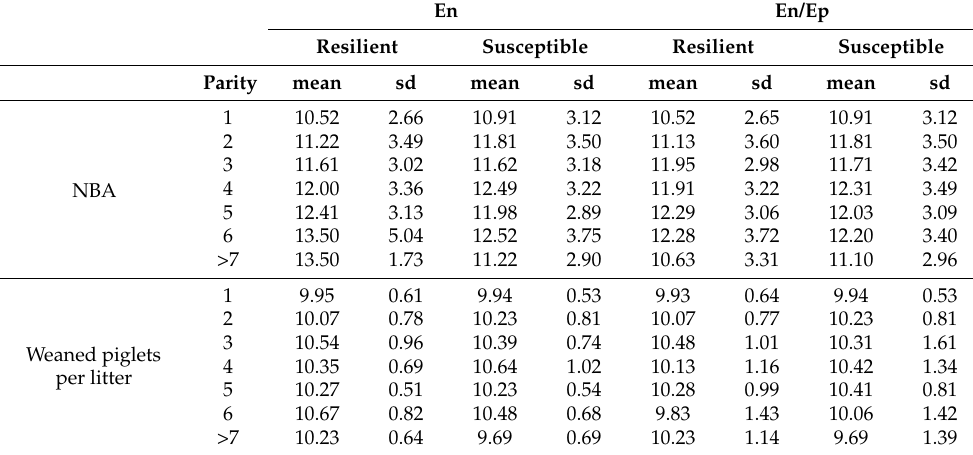
Table 4. Number of piglets born alive (NBA) and number of weaned piglets per litter from the data in the included farm from March 2016 to March 2019. Both parameters were obtained by splitting the observation period into an endemic period (from March 2016 to May 2018) and endemic and epidemic period (from March 2016 to March 2019). sd: standard